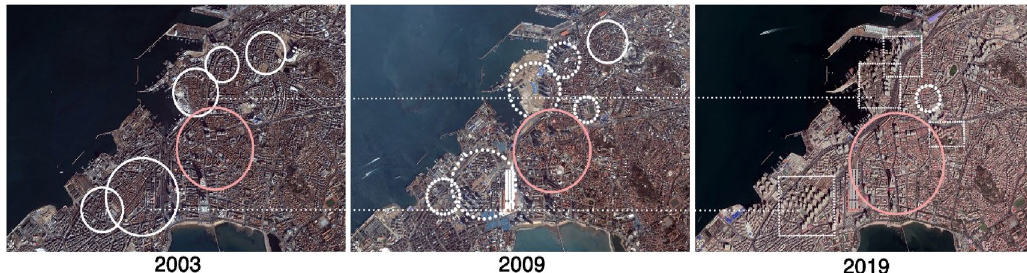
Figure 2. The shrinking of the distribution of Liyuan courtyard buildings in Qingdao.